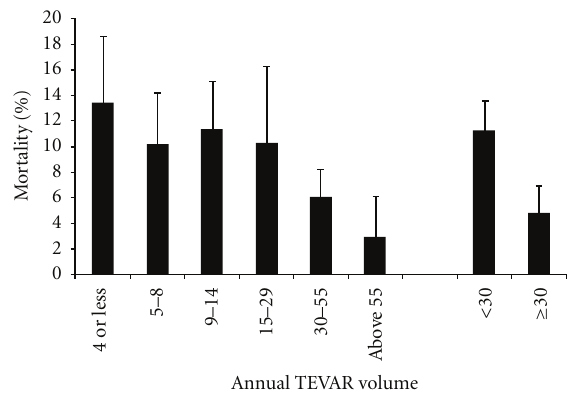
Figure 1: In-hospital mortality rates for emergently admitted TBAD patients undergoing TEVAR based on the annual hospital volume of TEVAR procedures performed. The following are the number of emergently admitted TBAD patients treated with endovascular repair in each TEVAR volume group: 1–4 ( n = 225), 5–8 ( n = 237), 9–14 ( n = 217), 15–29 ( n = 239), 30–55 ( n = 241), greater than 55 ( n = 167), less than 30 ( n = 917), 30 or more ( n =